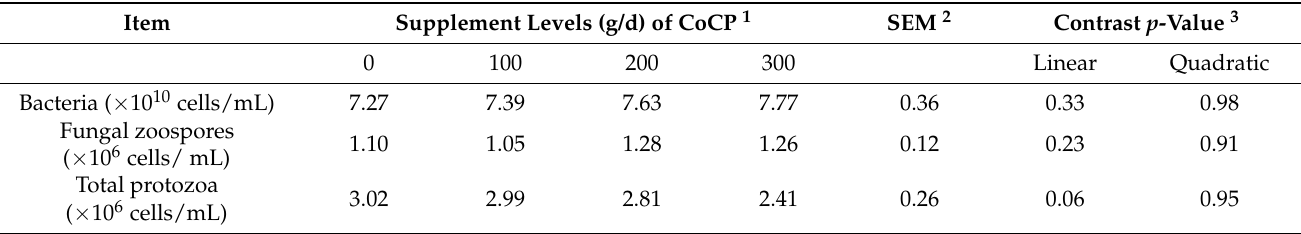
Table 5. Effects of dietary CoCP supplementation(g/d) on the microorganism count in the rumen.